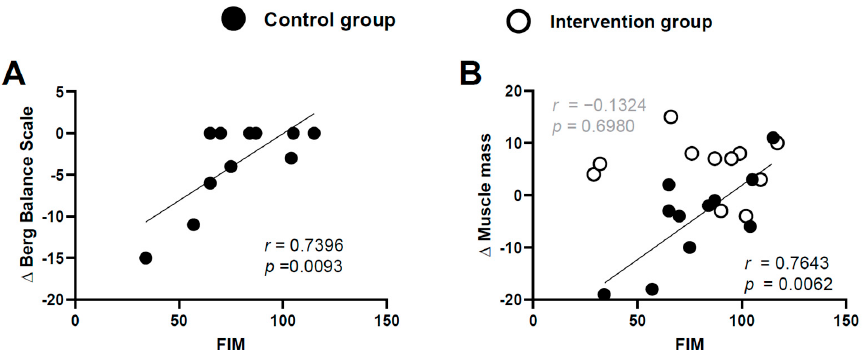
Figure 4. Correlations between the FIM score and Δ BBS ( A ) and Δ muscle mass ( B ) in the control group and the intervention group. Strong correlations were observed between the FIM score and Δ muscle mass and Δ BBS in the control group; this finding was not observed for the intervention group (Bonferroni correction; critical alpha <0.05/2 = 0.025). Data from the intervention group are